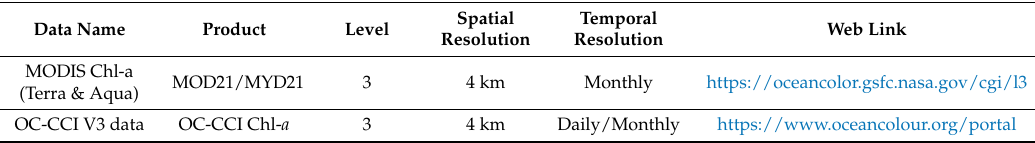
Table 2. The characteristics and source of data used in this study. OC-CCI: Ocean Color Climate Change Initiative; GHRSST: Group for High Resolution Sea Surface Temperature; ASCAT: Advanced Scatterometer; OSCAR: Ocean Surface Current Analyses Real-time; MLD: mixed layer depth; SSH: sea surface height; AOD: aerosol optical depth; HYCOM: HYbrid Coordinate Ocean Model; SST: sea surface